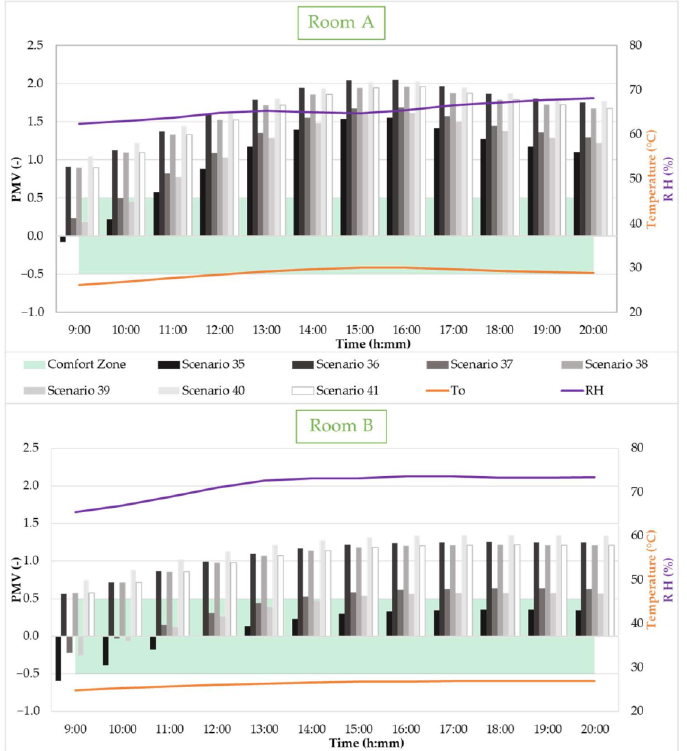
Figure 16. Hourly operative temperature, relative humidity, and PMV in rooms A and B with an out-of-bed patient: different scenarios in the autumn